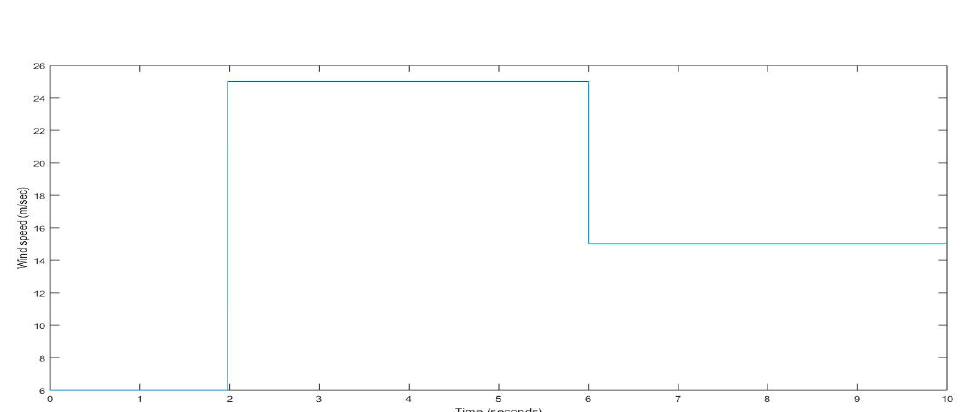
Figure 8. Wind variation in time for Case 3.